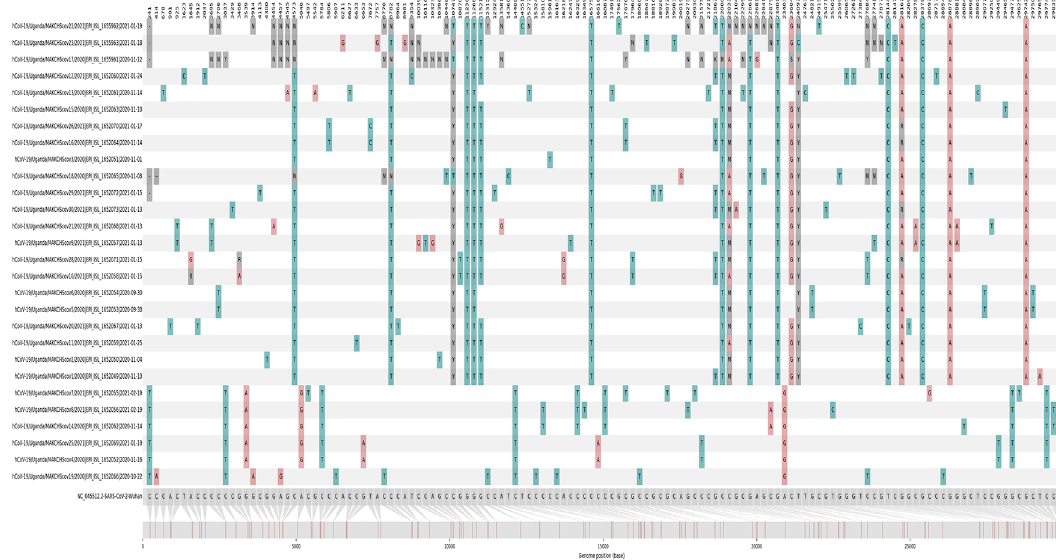
Figure 2. Nucleotide alignment showing variants covering the SARS-CoV-2 sample genome